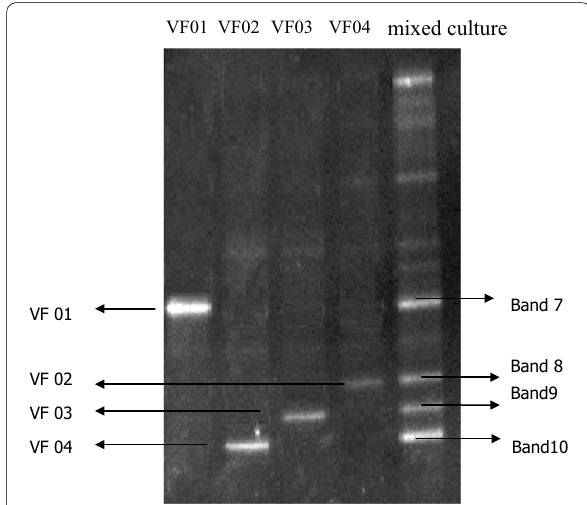
Fig. 2 Analysis using DGGE and comparison of V3 fragments derived from enrichment culture and bacterial isolates ( lane VF01 – VF04 isolates from the activated sludge; Lane mixed culture mixed culture at 14th day of